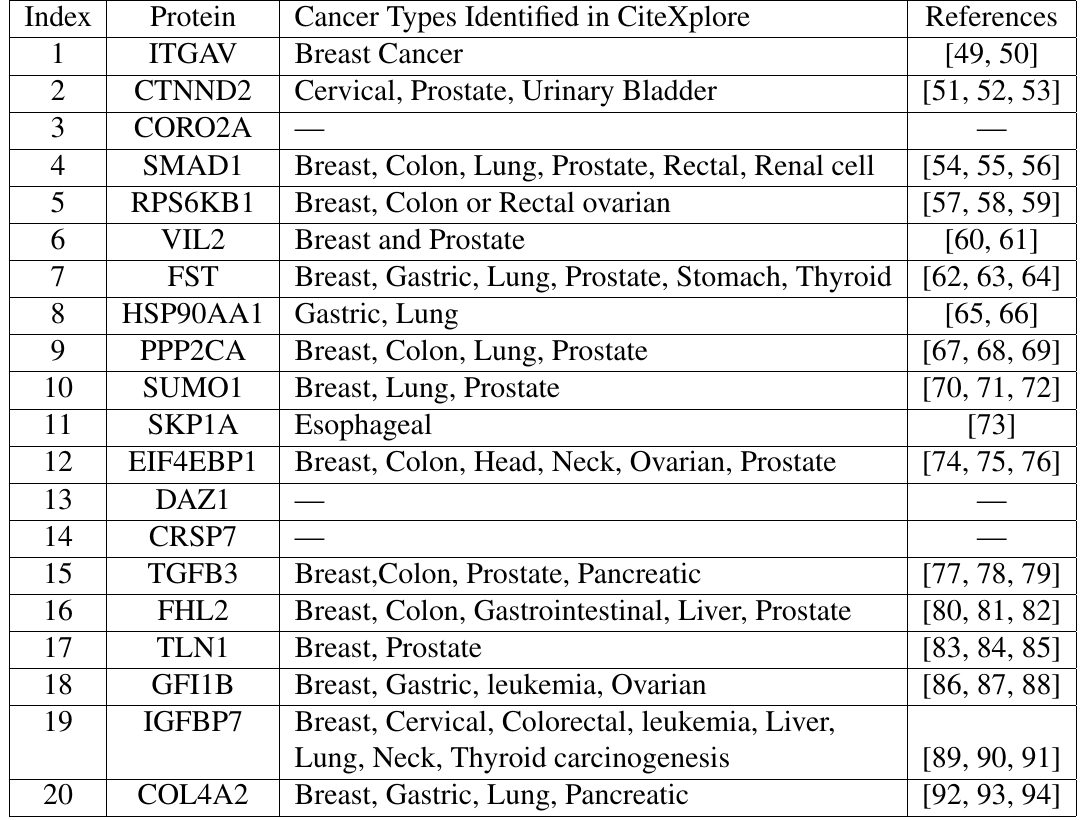
Figure 7: Comparing different proposed methods with their corresponding Random versions. The feature selection algorithm does not matter very much for the disToCancer method, with 9% improvement in F-measure over the Random version, but it matters a lot for the FS method, with 26% improvement in F-measure comparing to the Random version. Table 9: Capacity Identification of New Cancer-Related